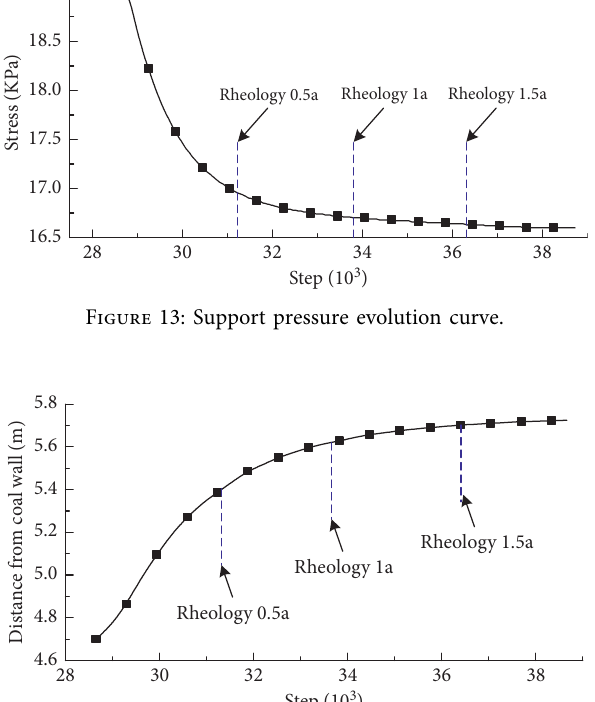
Table 5: Rheological model parameters.